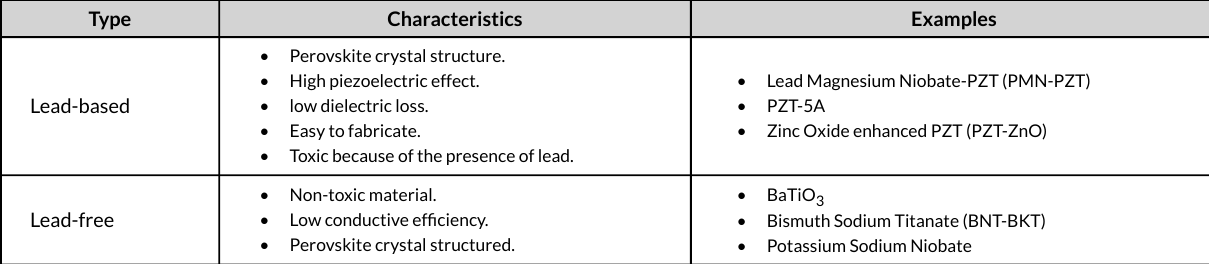
Table 1. Characteristics of Piezoceramics Material Types. 10 Type